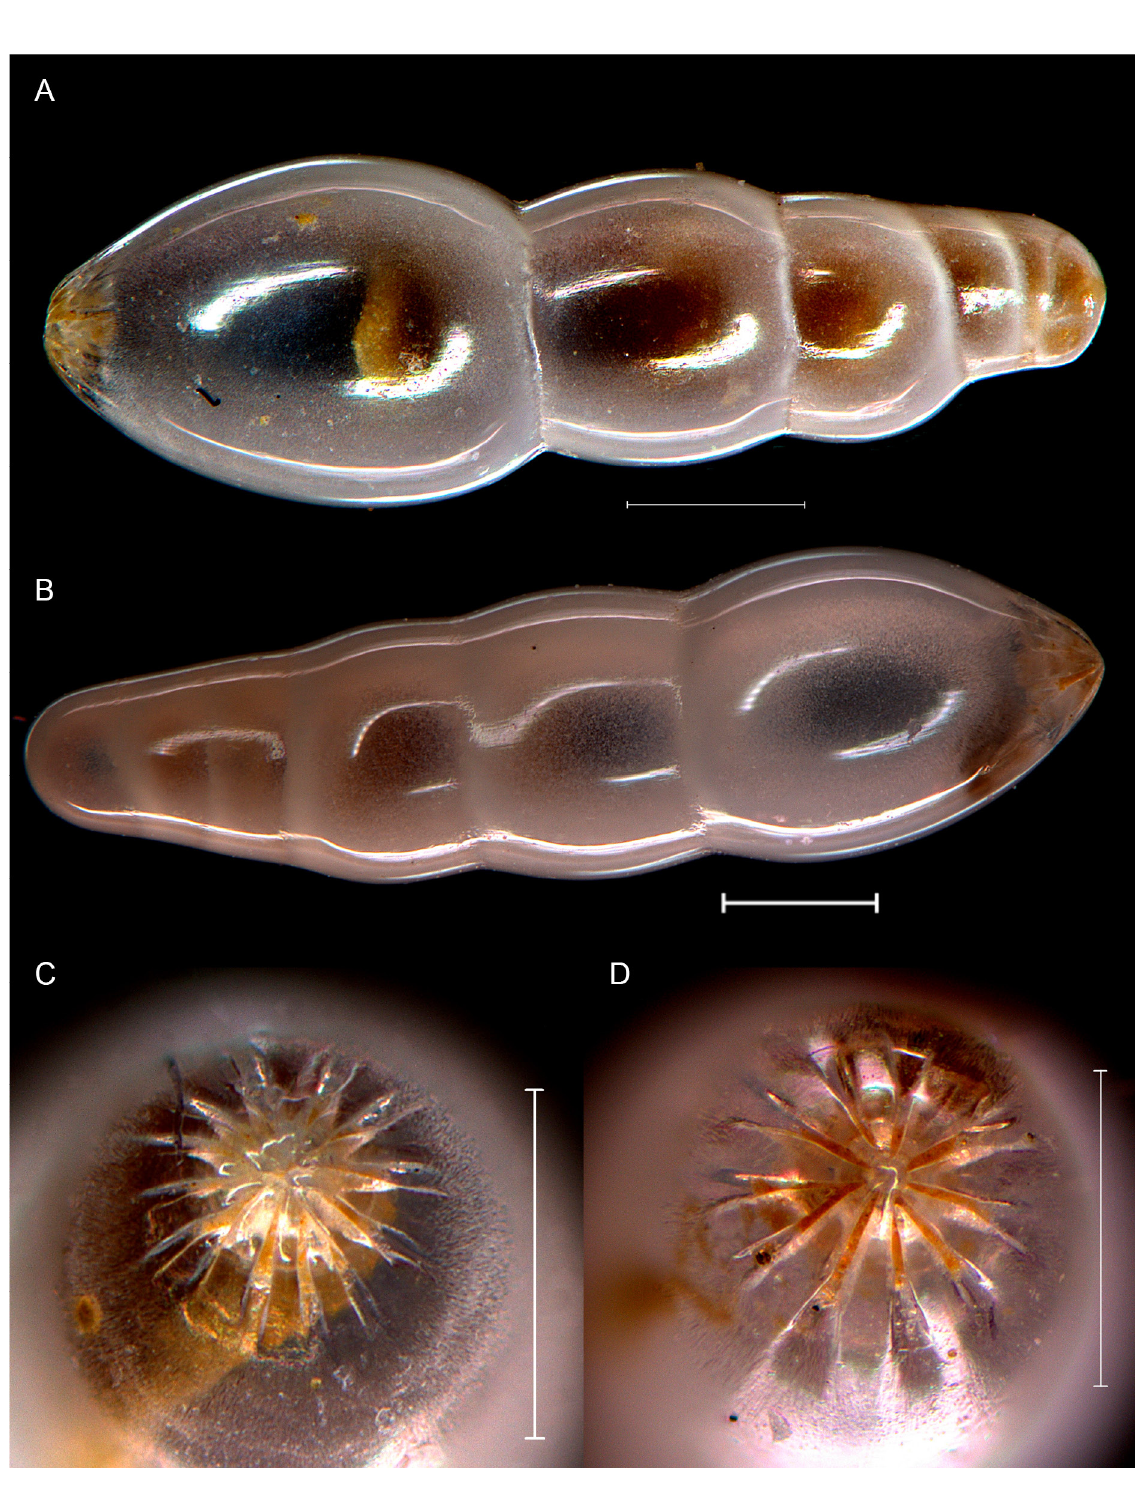
Fig. 14. Nodosaria incerta Neugeboren, 1856. A, C . Microsphere (BIOICE 2664, IINH 40071), side view (A), showing initial spiral end, and aperture (C). B, D . Megalosphere (BIOICE 3108, IINH 40085), side view (B) and aperture (D). Light source combination of incident light and dark field. Scale bars = 0.25